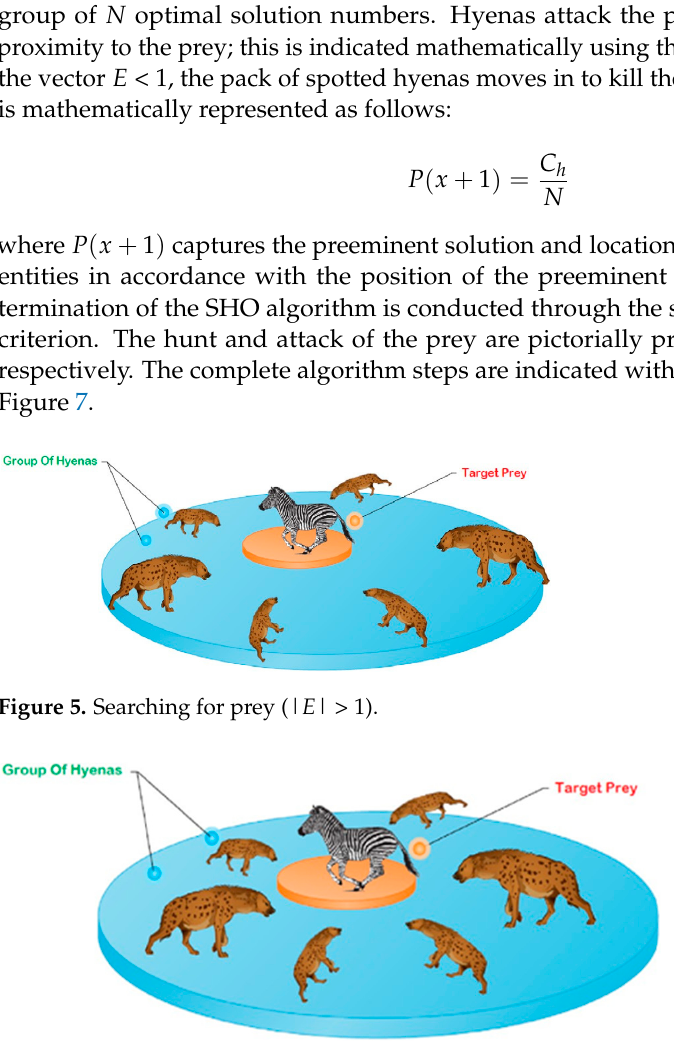
Figure 6. Attacking prey (| E | < 1).